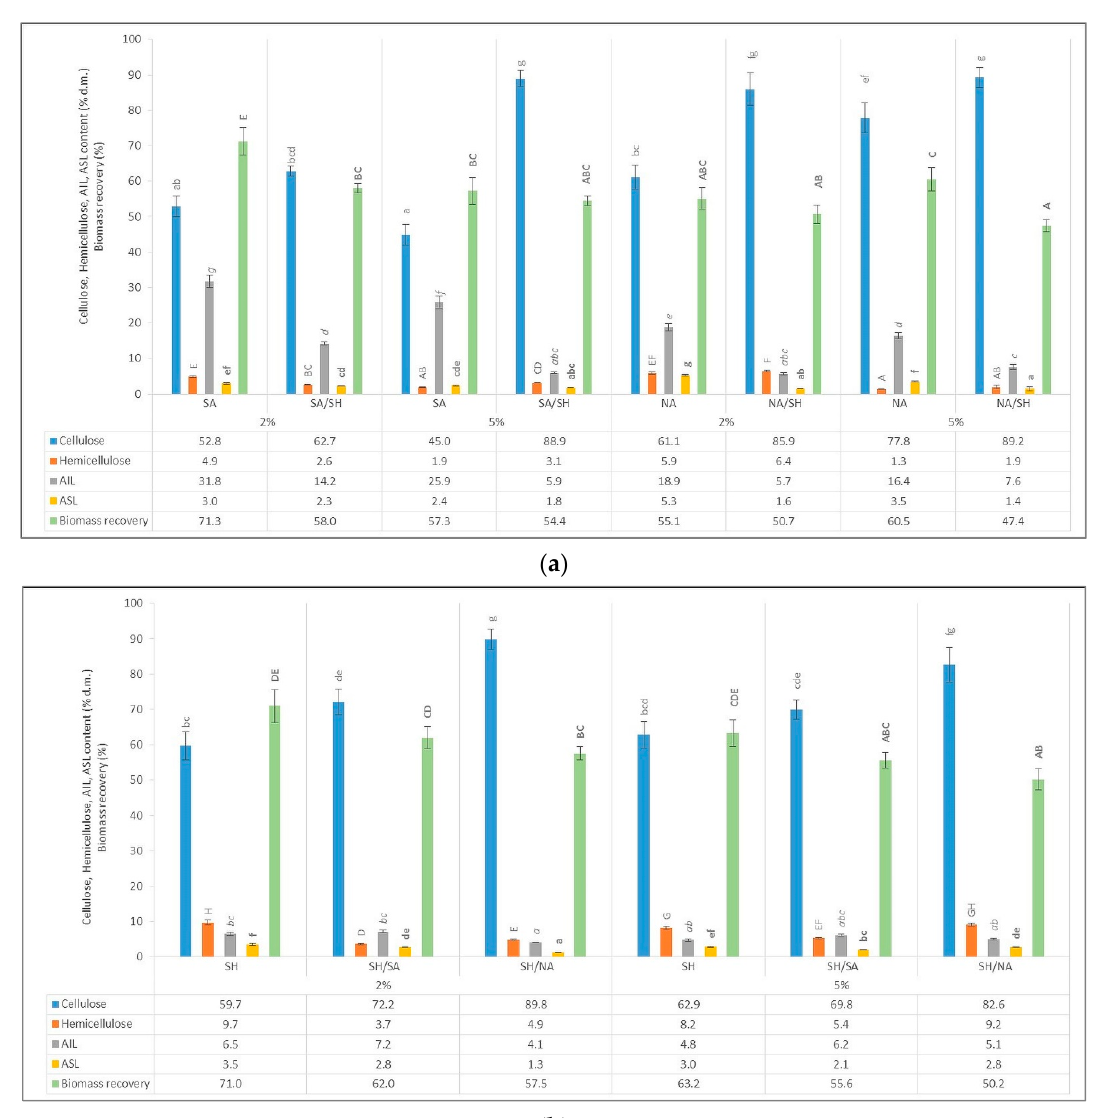
Figure 1. Effect of single and two-stage acid-alkali ( a ) and alkali-acid ( b ) pretreatment on the chemical composition of pretreated JAS and biomass recovery. SA—sulfuric acid; NA—nitric acid; SH—sodium hydroxide; AIL—acid insoluble lignin; ASL—acid-soluble lignin. Different lower-case letters indicate significant differences (p < 0.05) between the mean values of the cellulose content (two-way ANOVA, Tukey’s post-hoc test). Different capital letters indicate significant differences (p < 0.05) between the mean values of the hemicellulose content (two-way ANOVA, Tukey’s post-hoc test). Different lower-case letters in italic, indicate significant differences (p < 0.05) between the mean values of the AIL content (two-way ANOVA, Tukey’s post-hoc test). Different lower-case letters in bold, indicate significant differences (p < 0.05) between the mean values of the ASL content (two-way ANOVA, Tukey’s post-hoc test). Di ff erent capital letters in bold, indicate significant di ff erences (p < 0.05) between the mean values of the biomass recovery (two-way ANOVA, Tukey’s post-hoc